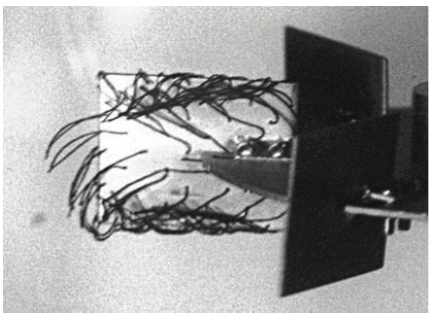
Figure 7: Telltales on D-6 impeller